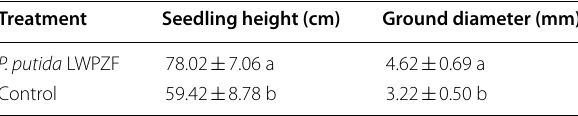
Different letters indicate significant differences ( P <